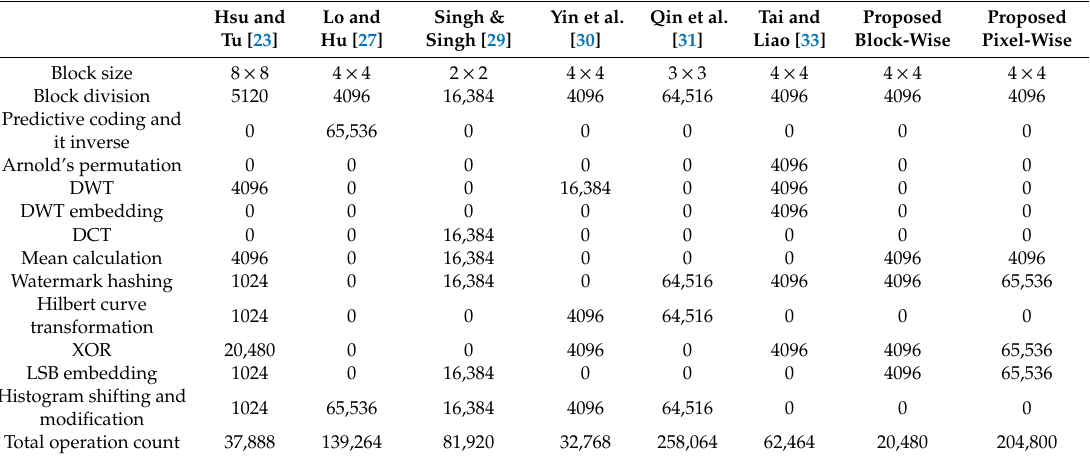
Table 9. Processing complexity